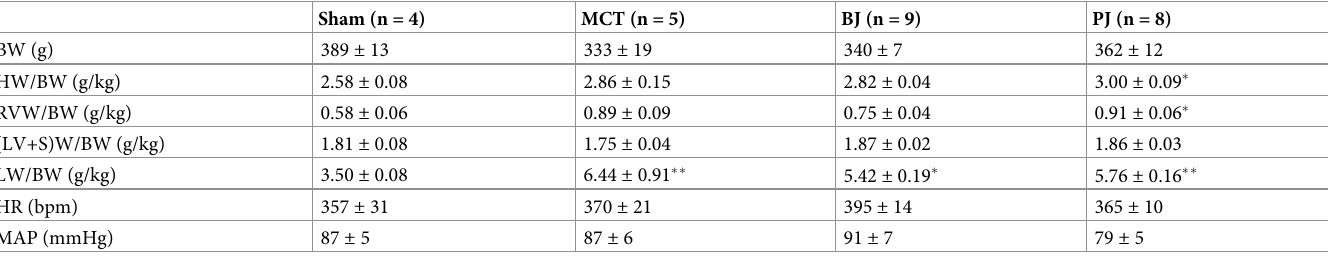
Table 2. Effects of nitrate-depleted BJ supplementation on various